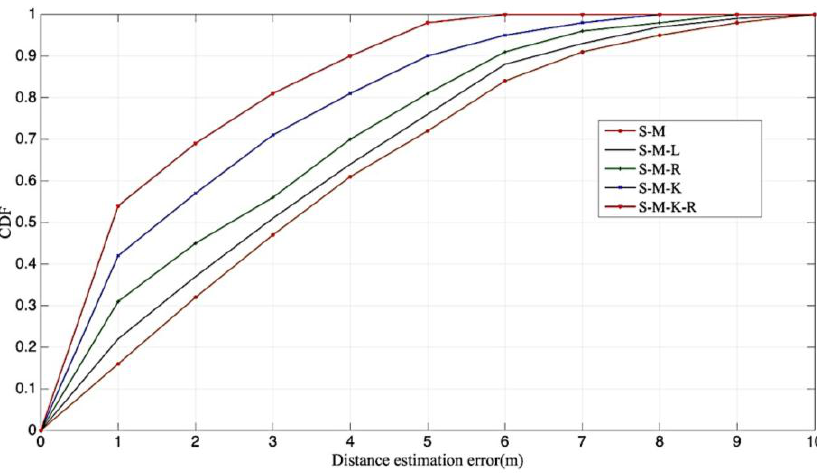
Table 1. Remarkable sets of features.